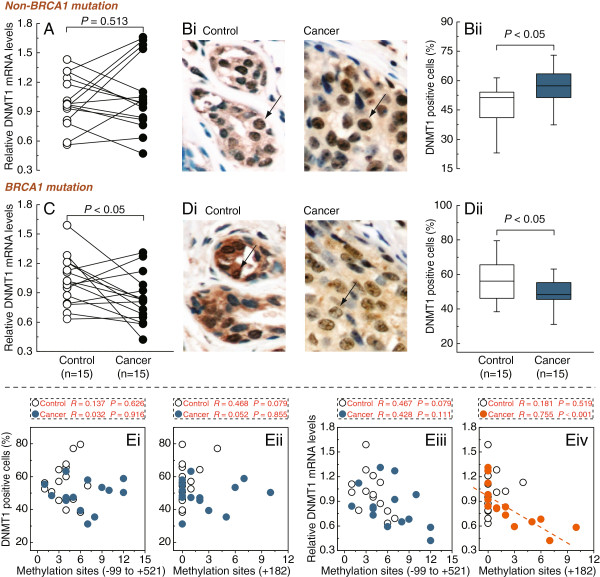
Expression patterns of DNMT1 in BRCA1-mutated and non-mutated breast cancer. A and C, relative DNMT1 mRNA levels were measured in non-mutated and BRCA1-mutated breast cancer, and their adjacent normal breast tissues. Bi and Di, sections were subjected to immunostaining for DNMT1 in non-mutated and BRCA1-mutated breast cancer, and their adjacent normal breast tissues. Arrow shows positive staining for DNMT1 in the nuclei. Bii and Dii, summary of the percentages of DNMT1-positive cells from the measurements shown in Bi and Di, respectively. Magnification is 400×. Ei and Eii, correlation between the DNMT1-positive cells and methylated sites (+182) or (-99 to +521) in BRCA1-mutated breast cancer and adjacent normal breast tissues. Eiii and Eiv, correlation between the relative DNMT1 mRNA levels and methylated sites (+182) or (-99 to +521) in BRCA1-mutated breast cancer and adjacent normal breast tissues. Open circles, normal breast tissues; closed circles, breast cancer tissues (each group n = 15).